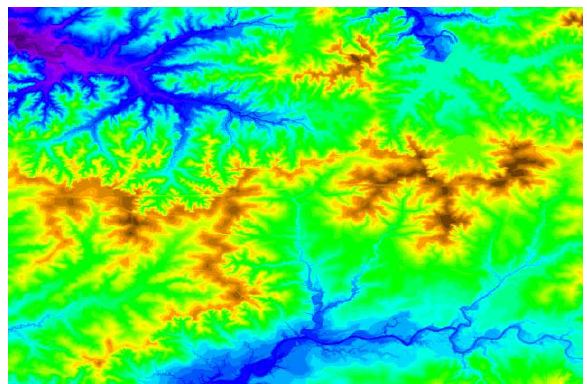
Figure 7. Digital Terrain Model of North Tehran